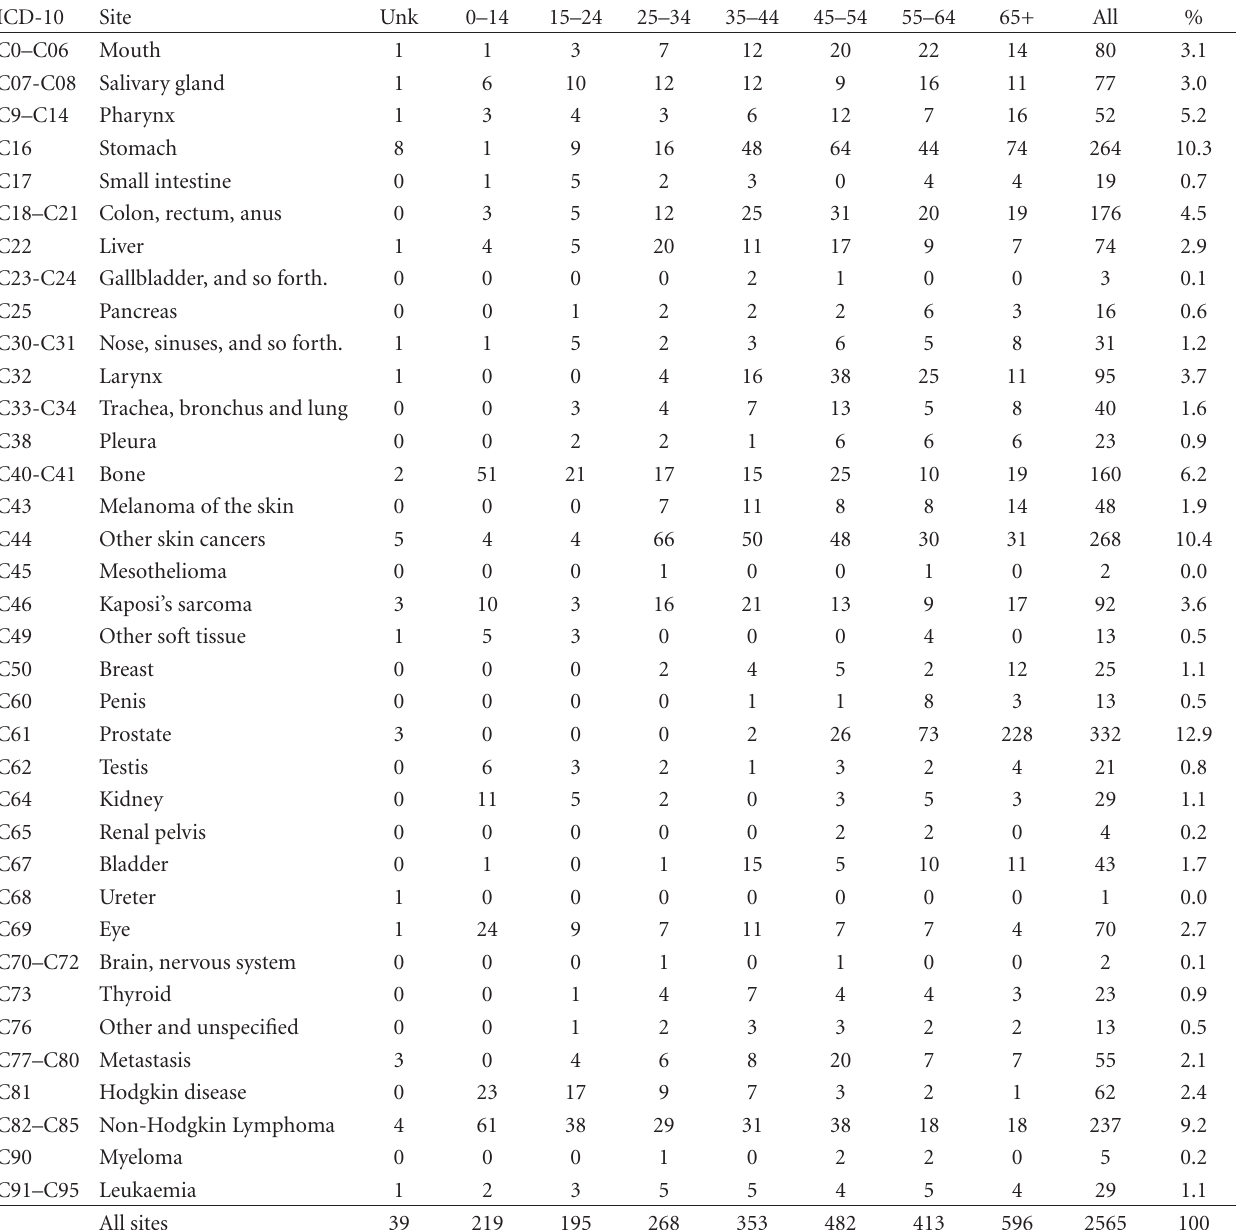
Table 2: Distribution of cancers by site and age in